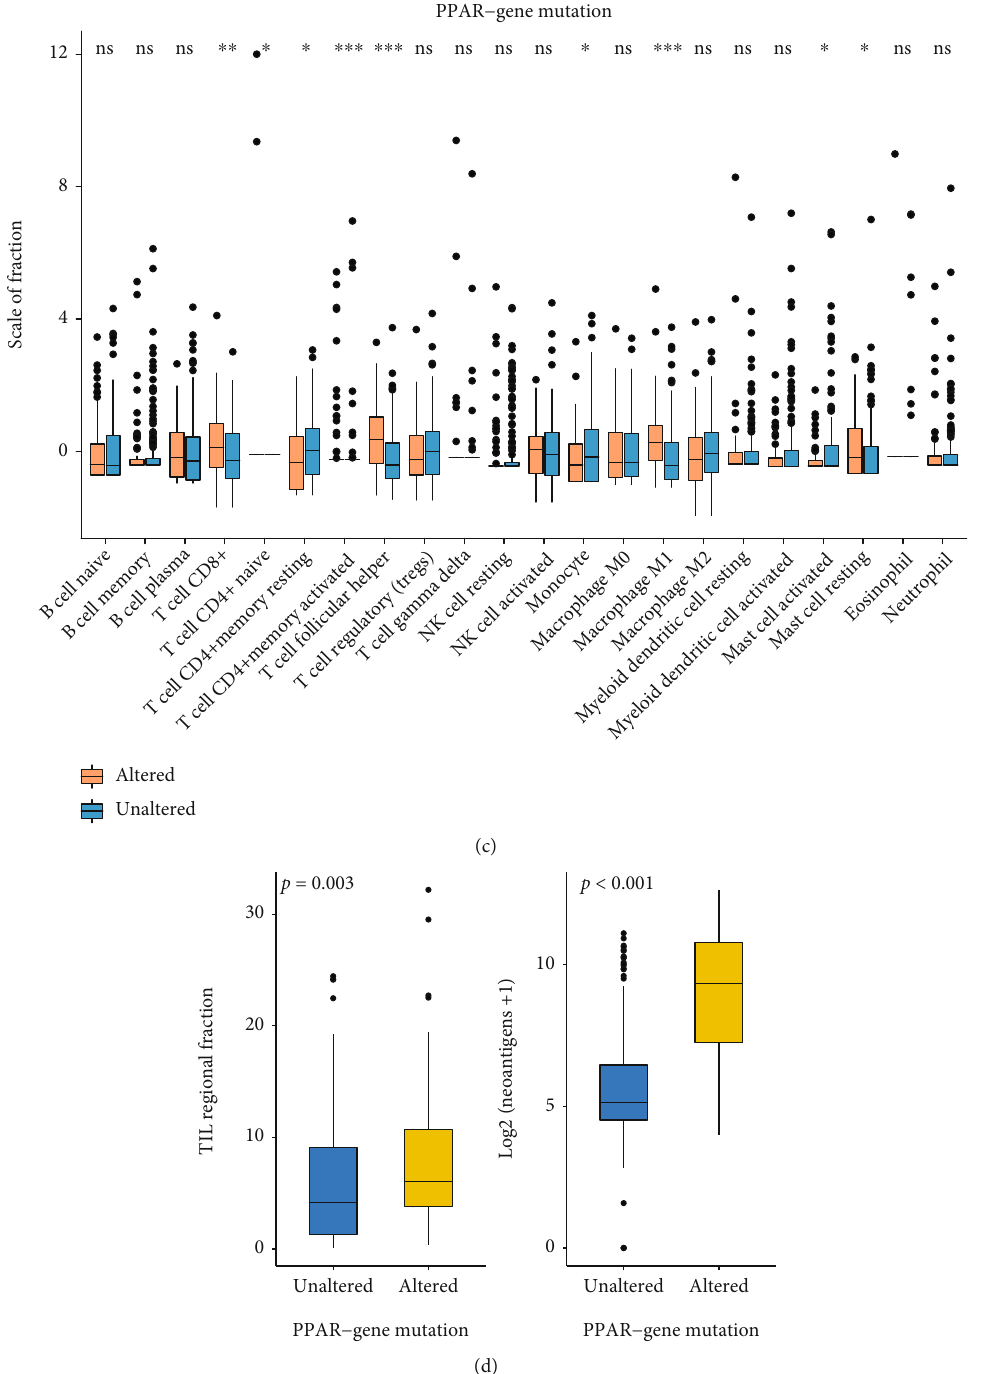
Figure 4: Tumor immune characteristics of patients with PPAR-related gene altered patients and unaltered patients. The relative abundance of tumor-in fi ltrating leukocytes (TILs) and neoantigens grouped by PPAR-related gene CNA status (a, b) and PPAR-related gene mutation status (c, d) in